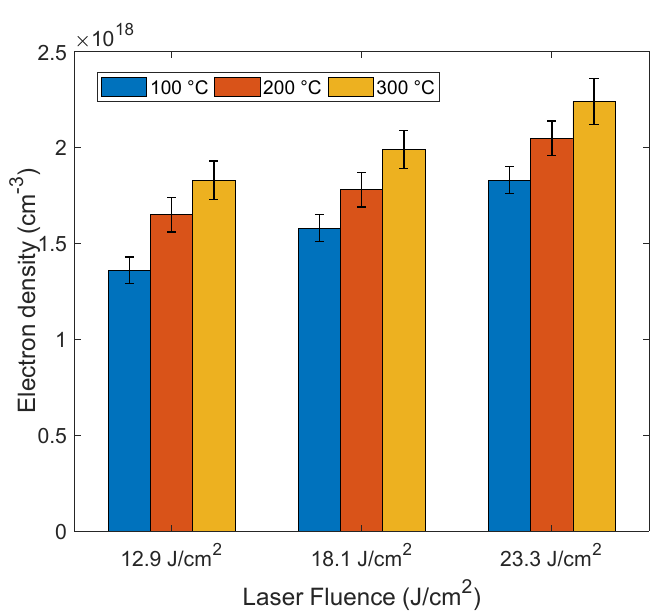
Figure 9. Electron density of the Mg plasma as a function of laser fluence of at different sample temperatures.